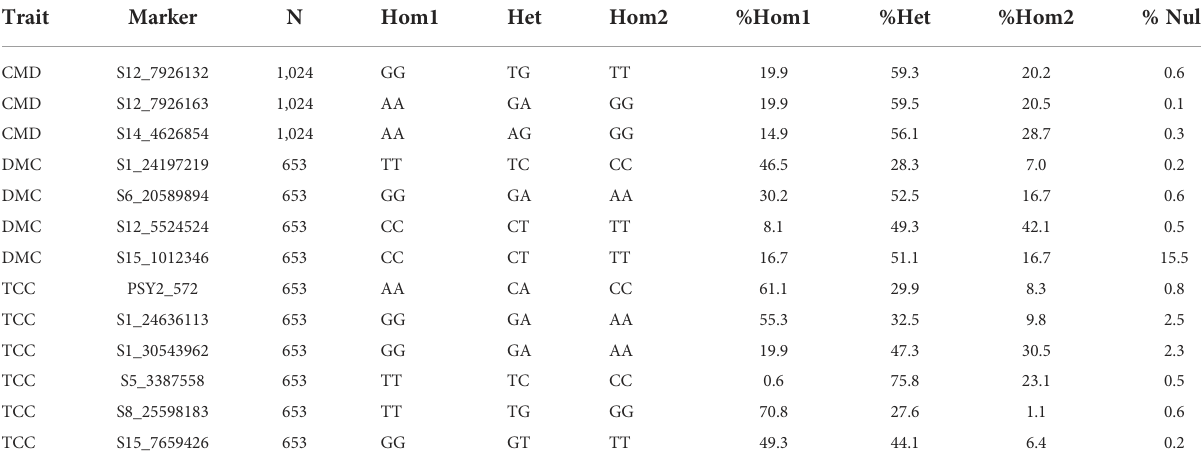
TABLE 2 Frequency of 13 KASP marker genotypes segregating for CMD, DMC and TCC in Uganda ’ s cassava breeding